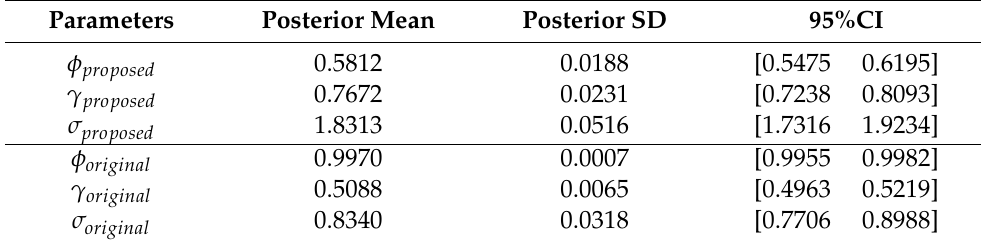
Table 33. Comparison of estimated parameters (23 June 2016, TMC, Aichi, Japan.).